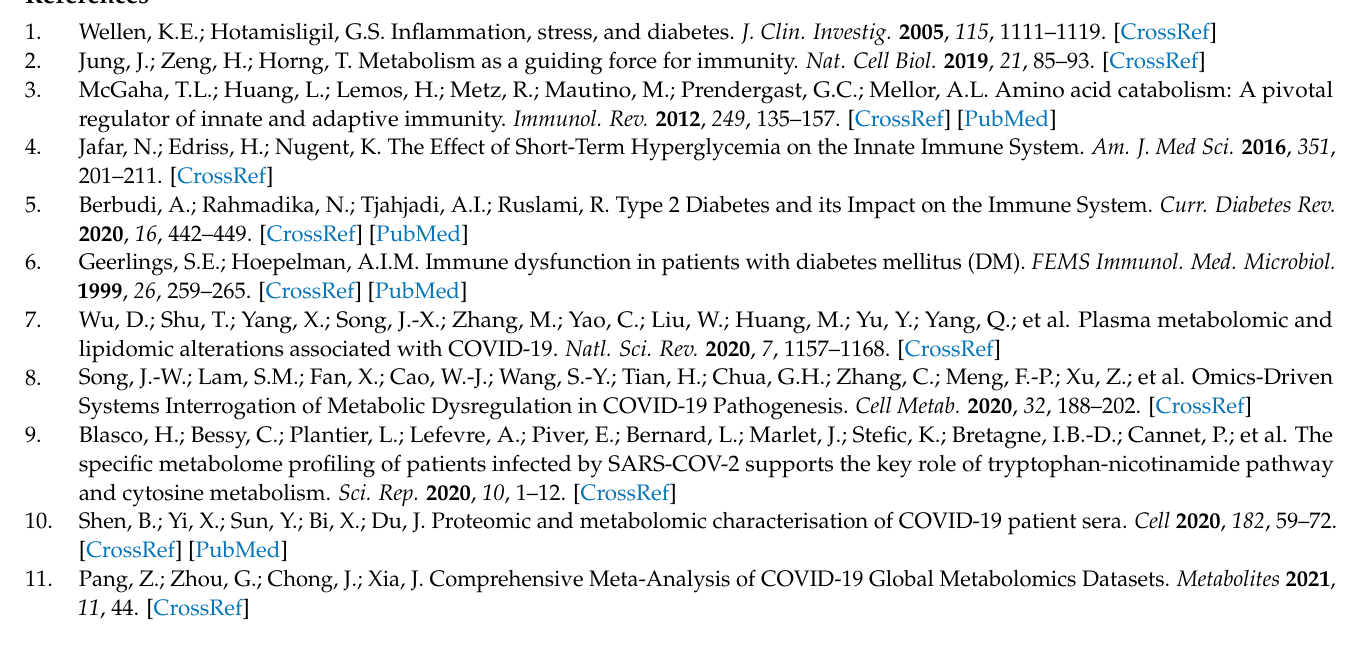
fed relative concentrations of plasma metabolites, and analyses were run in metaboanalyst [16]. Figure S2. The relative changes in two metabolites closely related to energy metabolism—glucose and 3-hydroxybutyrate—where both Groups A and B were divided into subgroups according to patient diet (according to presence of diabetes) on Days 1, 3, and 7 after hospital arrival; not dia = non-diabetic patients on a normal diet, dia = diabetic patients on a diabetic diet. Values were relativized to median of controls set to